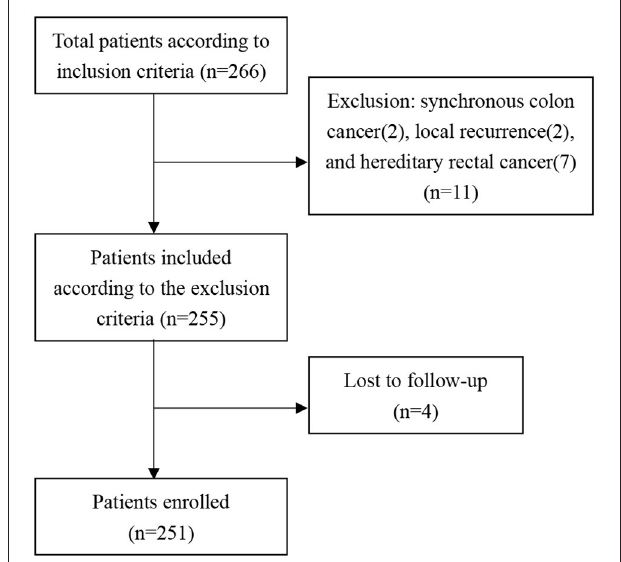
FIGURE 1 | Flow diagram of patient